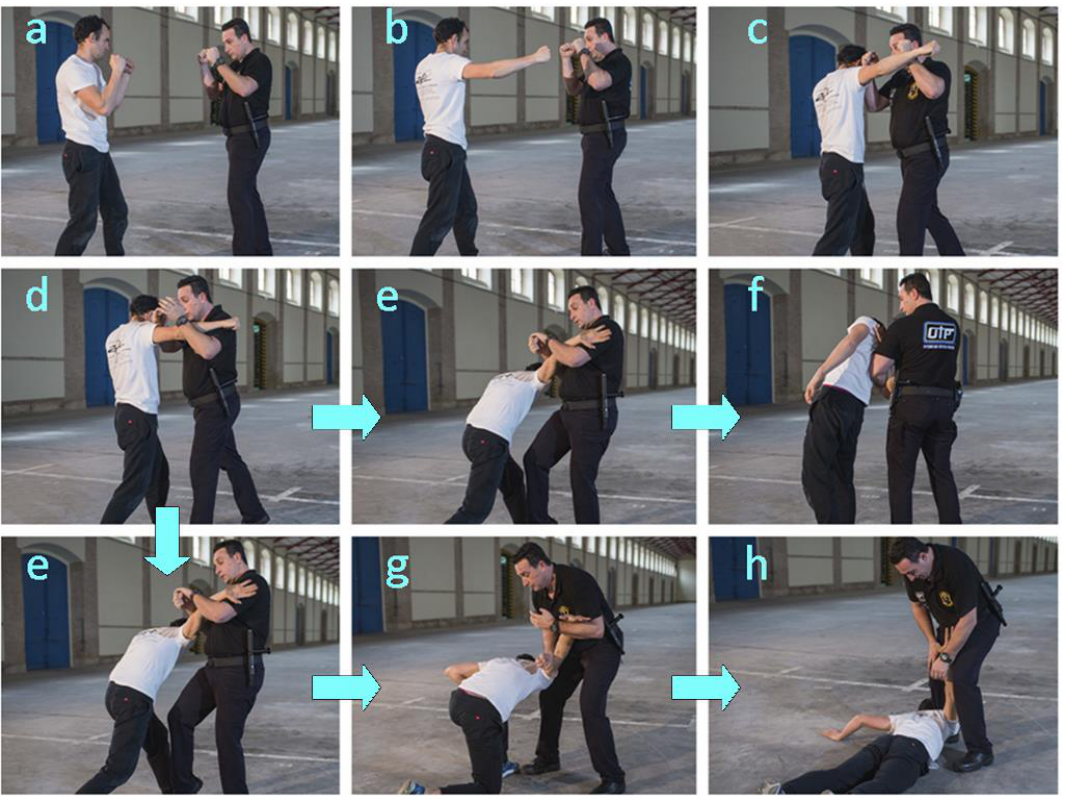
Figure 2. Steps of physical intervention techniques (PIT) 1 (response to a hooking punch). ( a ) The o ffi cer faces the opponent. ( b ) The opponent charges against the o ffi cer. ( c ) The o ffi cer with his forearms blocks the opponent’s forward arm. ( d ) The o ffi cer releases the arm he previously used to block the opponent’s arm. ( e ) The o ffi cer’s previously released arm is used to grab the opponent break his balance with a knee blow on the opponent’s backward leg. After this picture the arrows indicate the flow of motion between the o ffi cer and opponent. The latter can be subdued in two di ff erent ways (as are pictured in f or g-h). ( f ) While standing, the o ffi cer controls the opponent by using his forearm to exert strong pressure on the opponent’s elbow. ( g ) The o ffi cer controls the opponent with the same forearm in order to lower it and keep it bent. ( h ) The o ffi cer continues to exert further pressure with the forearm to take the opponent to the ground.